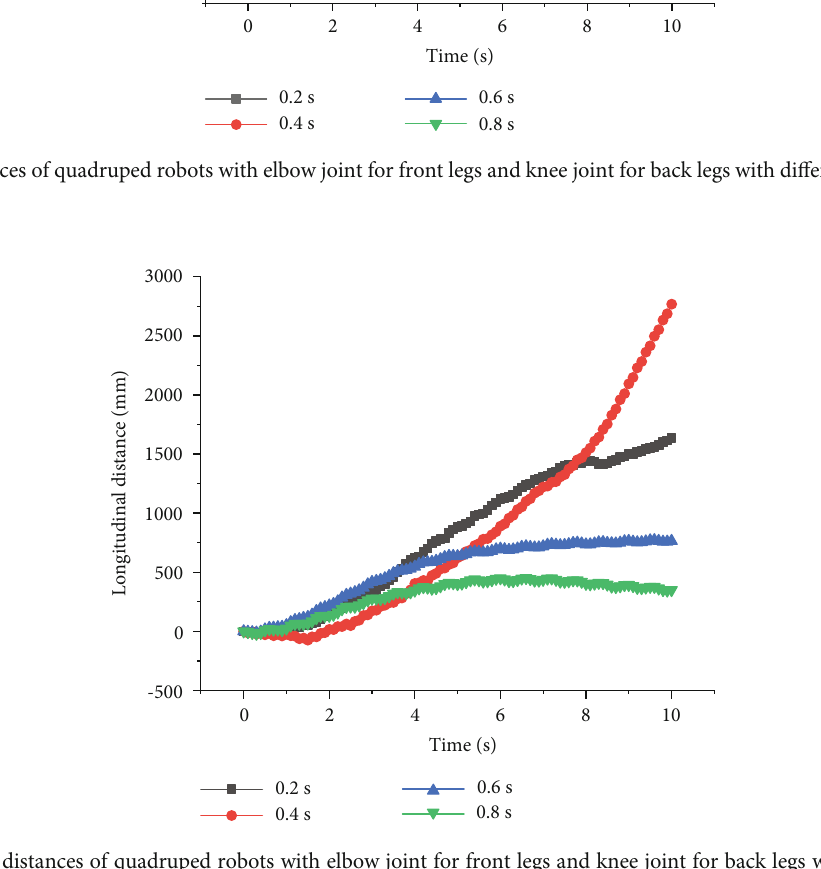
Figure 6: Longitudinal distances of quadruped robots with elbow joint for front legs and knee joint for back legs with di ff erent period at a constant speed.